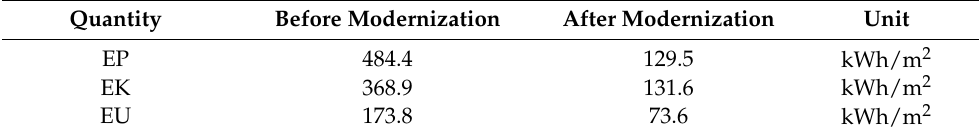
Table 5. Effectiveness of the